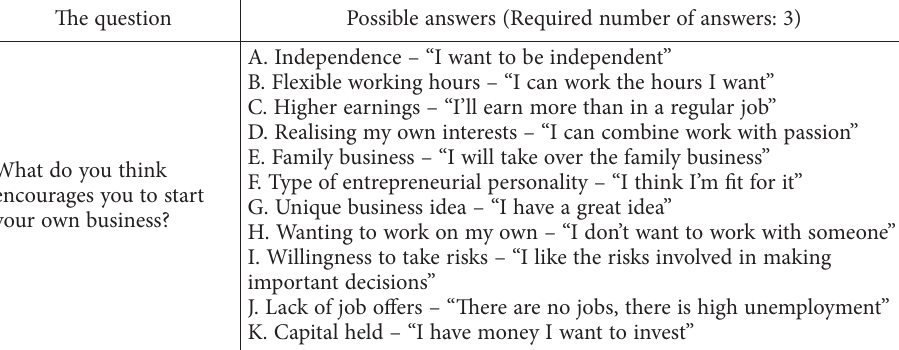
Table 3. Description of the question concerning the factors encouraging students to start a company The question Possible answers (Required number of answers: